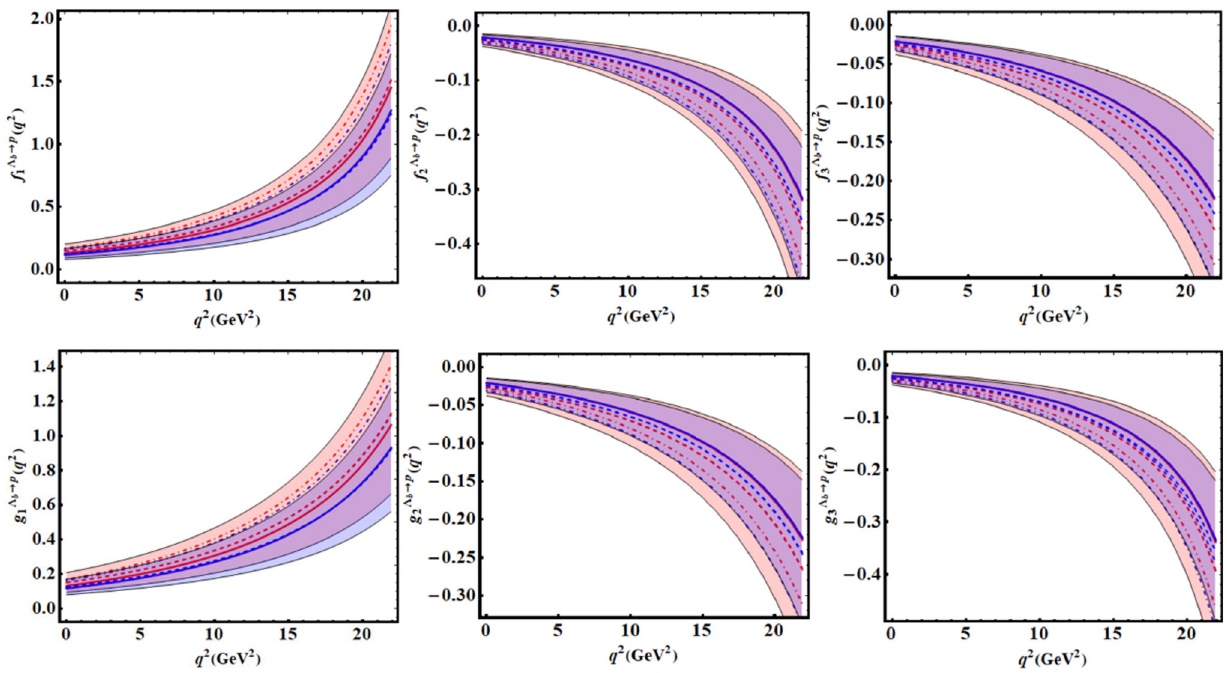
Fig. 2 (cid:2) b → p transitionformfactorobtainedfromLCSRat q 2 ≤ 10 GeV 2 and extrapolation to large q 2 using the z serizes-parametrization: the red(blue) solid line correspond to the Ioffe(tensor) current for pro- ton with QCDSR-LCDA model for (cid:2) b , the red(blue) dashed line cor- respond to the Ioffe(tensor) current for pronto with Exponential LCDA